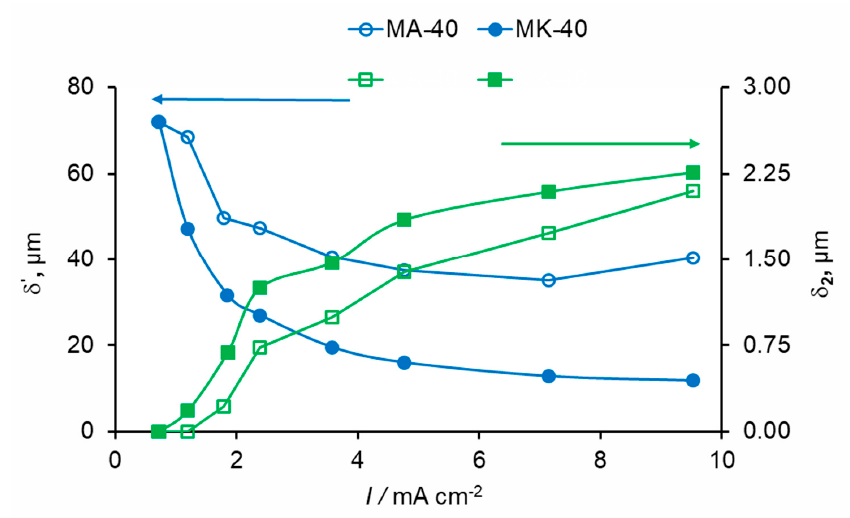
Figure 4. The e ff ective thicknesses of the di ff usion layer, δ (cid:48) , and the thickness of the extended SCR, δ 2 , as functions of the applied current density, for the AEM and CEM.